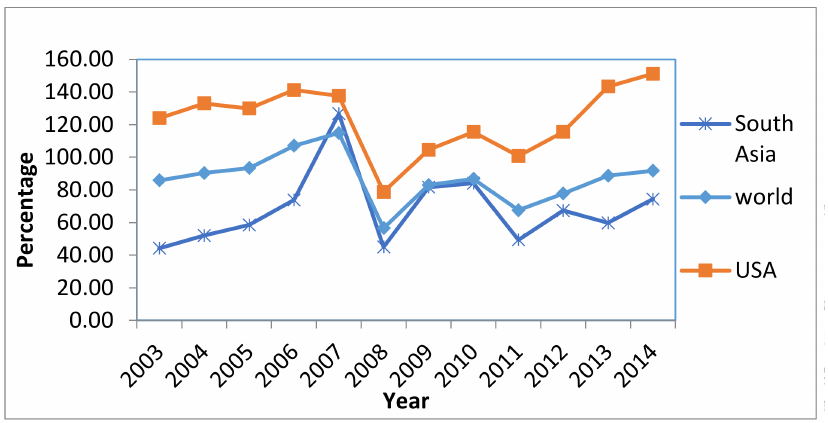
Figure 1. Market capitalization as a percentage of GDP (Source: World Development Indicators- World Bank).